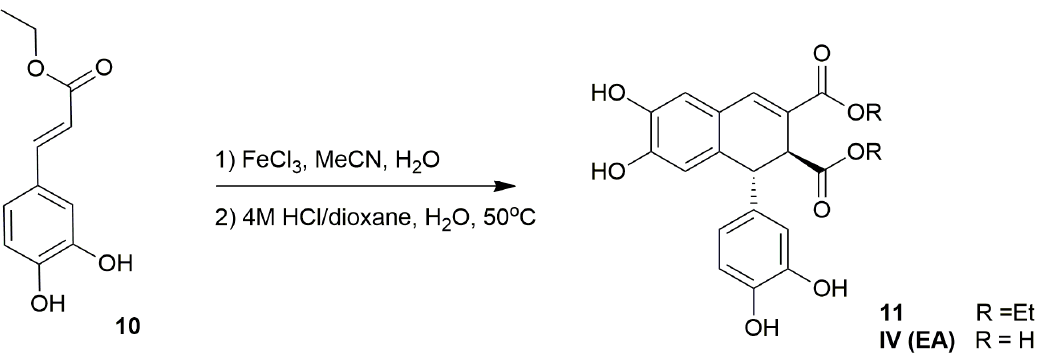
Scheme IV. Synthesis of epiphyllic acid IV